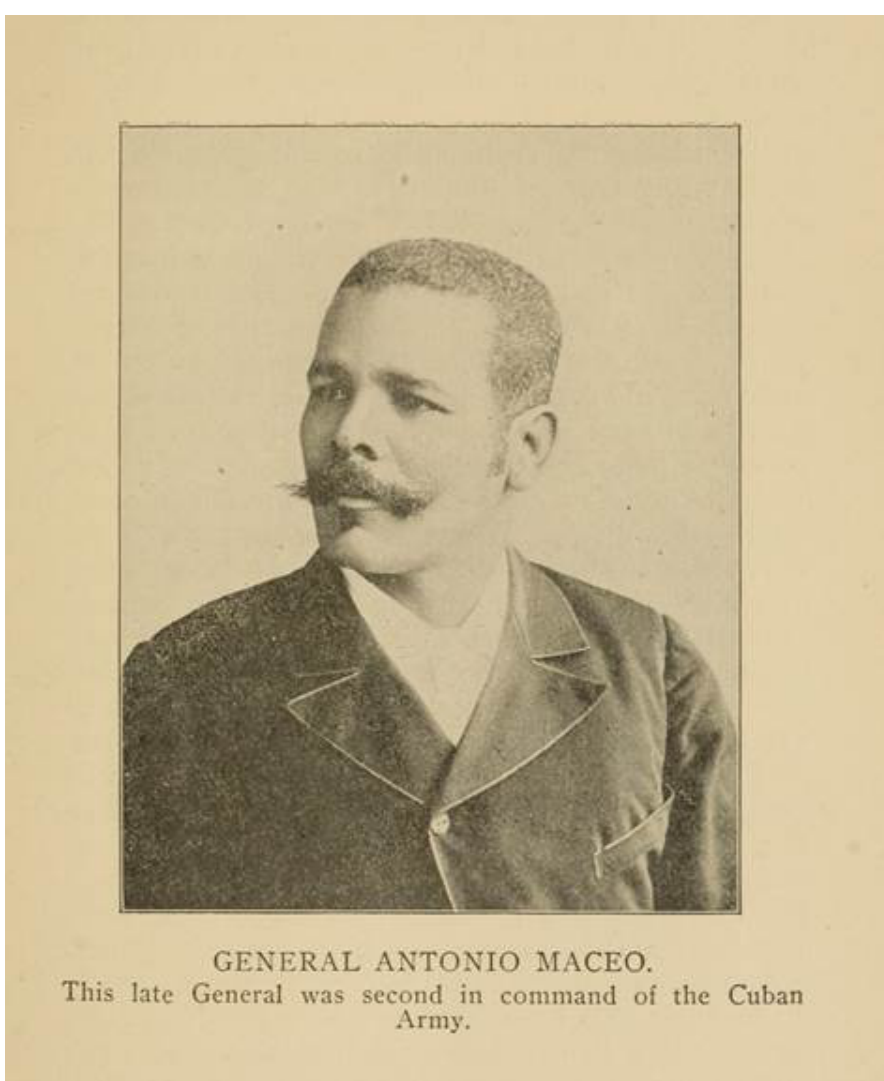
Figure 9 Portrait of Antonio Maceo from Booker T. Washington, Fannie Barrier Williams and Norman B. Wood, A New Negro for a New Century (1900),